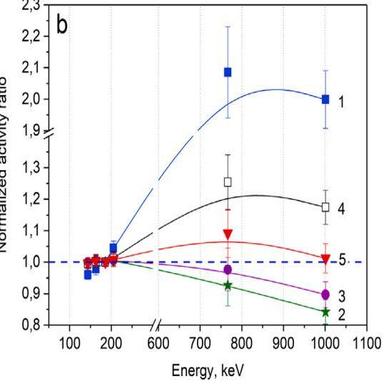
Line activity consistency evaluation.